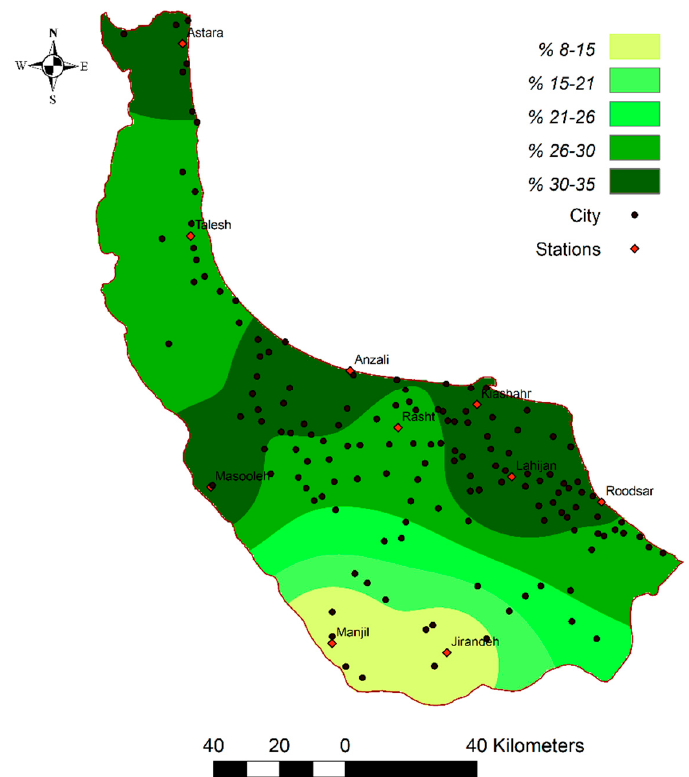
Figure 7. The spatial distribution of the RR (tank size 3 m 3 ) in Scenario B.